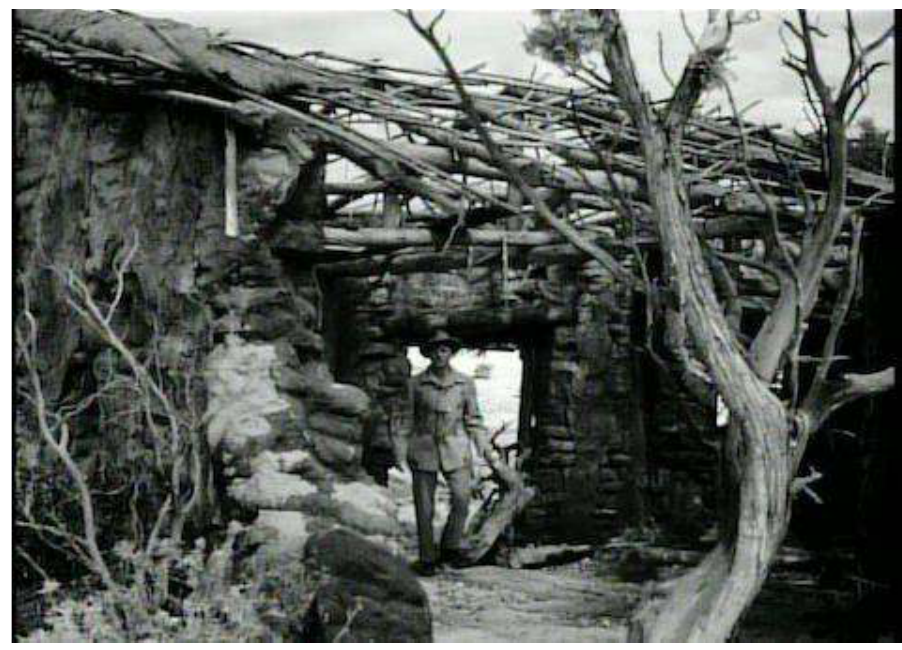
Raoul Walsh, between the Western and the Southern: Pursued (1947), Silver